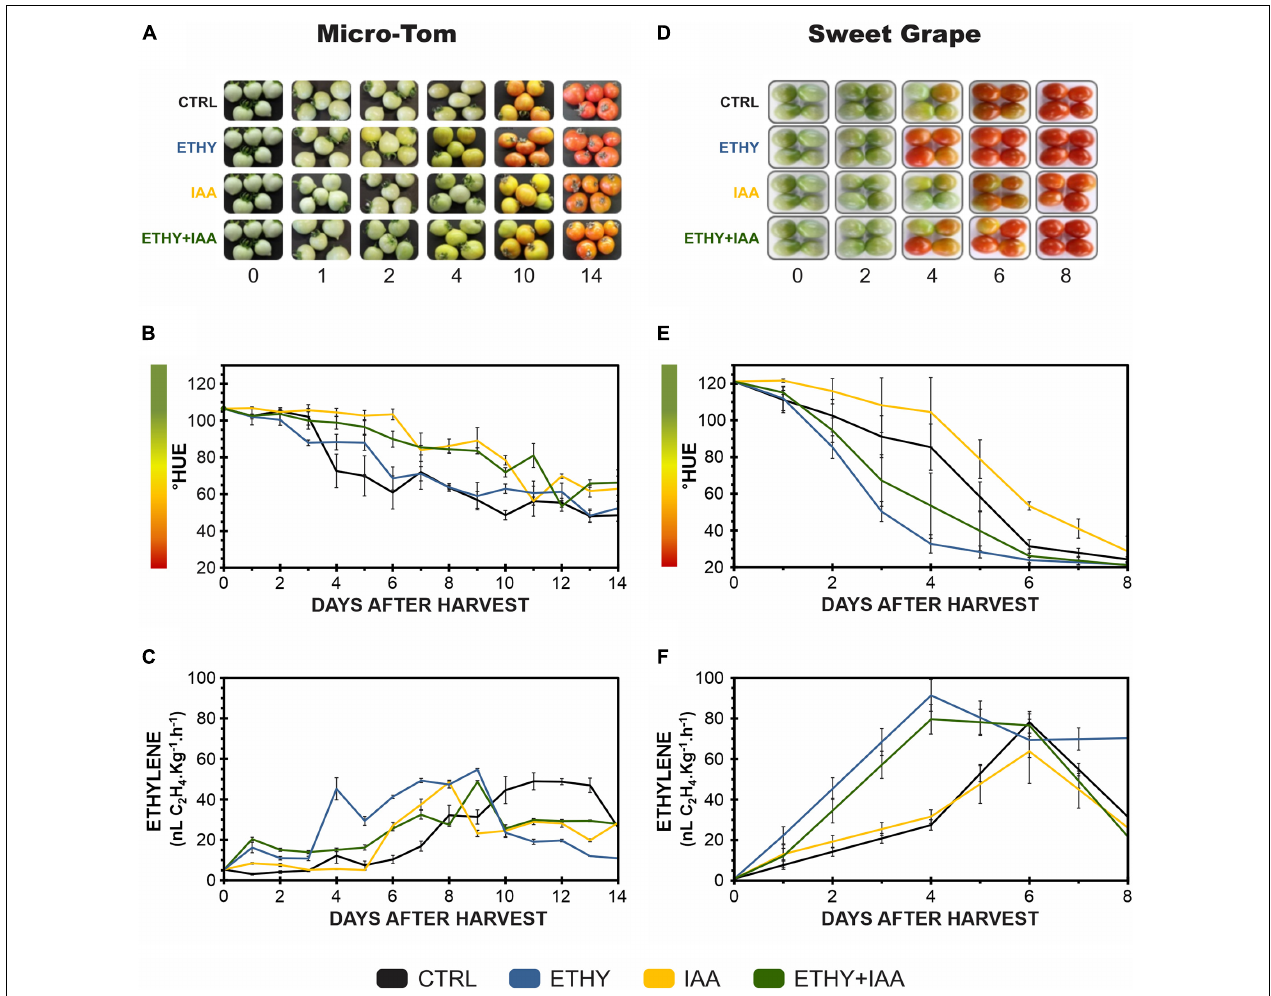
FIGURE 1 | Effects of ethylene, auxin, and both treatments on fruit color and ethylene emission during tomato ( Solanum lycopersicum L.) cv. Micro-Tom (A–C) and Sweet Grape (D–F) fruit ripening. (A,D) Illustrative photographs of tomato fruits. (B,E) Peel color expressed by hue angle. (C,F) Ethylene emission. CTRL,